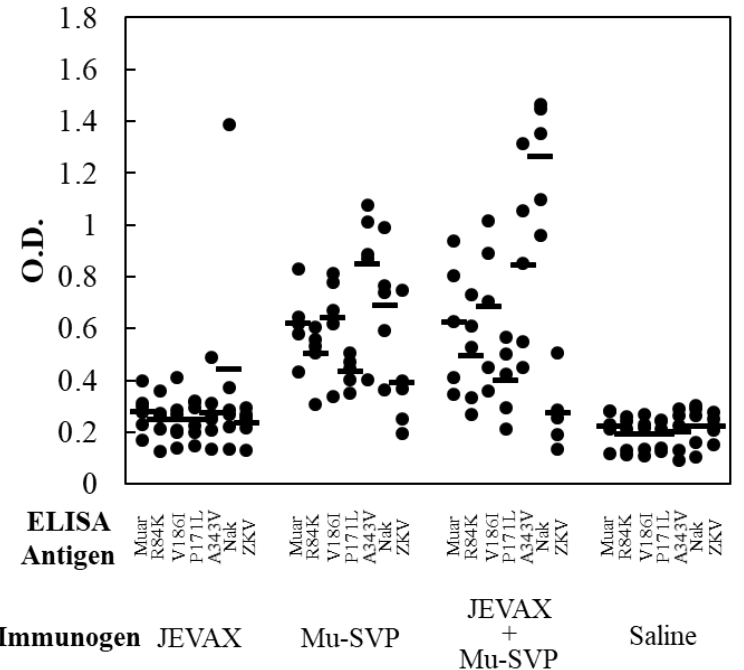
Figure 3. ELISA antibody levels induced by JEVAX and / or Muar-derived sub-viral particle (Mu-SVP). Antibody levels of individual mouse sera were examined on the antigen-sensitized plates. SVPs (Muar, R84K, V186I, P171L, A343V, Nak, and ZKV) were used as antigens. The individual sera were analyzed and bars represent the average of each group.